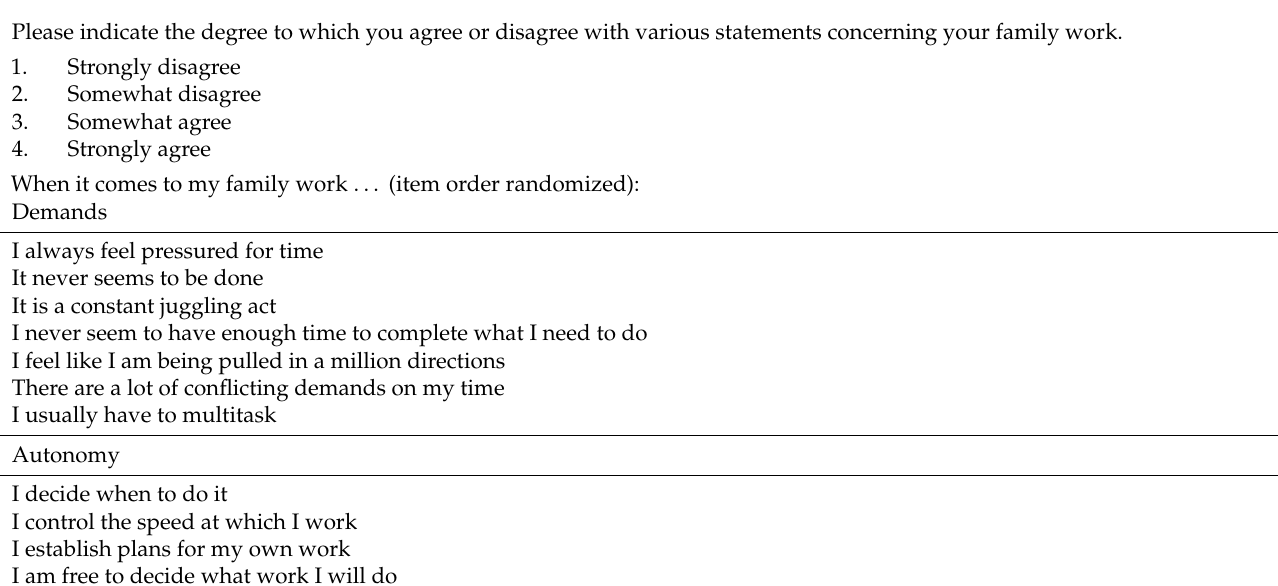
Table A1. Family Work Quality Questionnaire